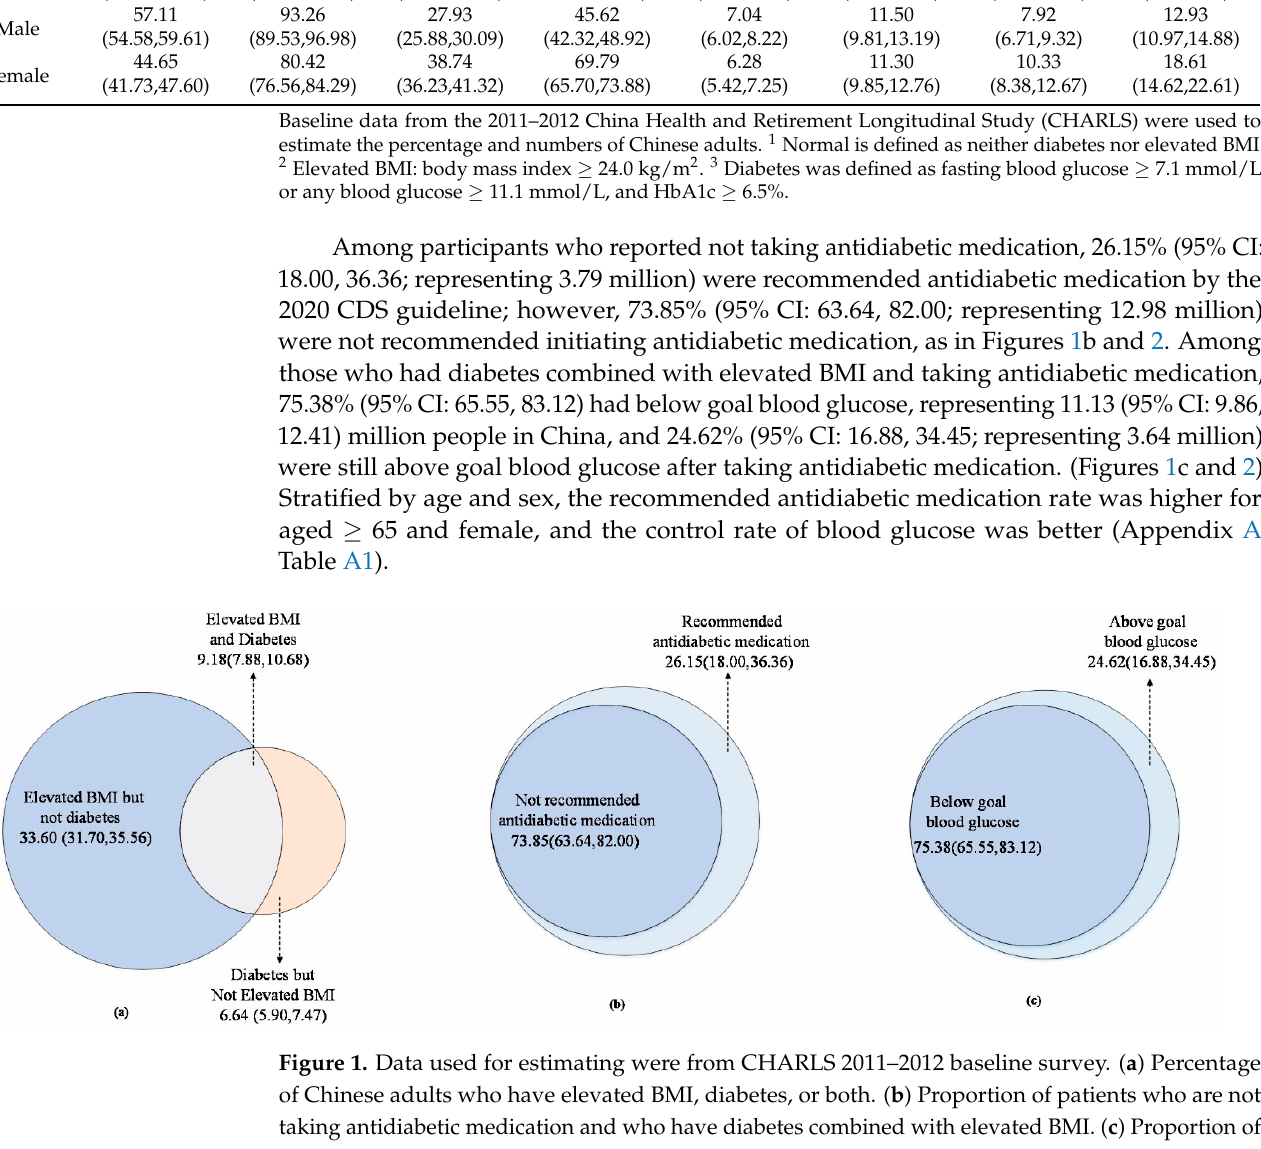
Figure 2. Number of Chinese adults who have elevated BMI, diabetes, or both, who are recom- mended initiating antidiabetic medication among those not taking antidiabetic medication and those with diabetes combined with elevated BMI or with above goal blood glucose among those taking antidiabetic medication. Data used for estimating were from the CHARLS 2011–2012 baseline survey.